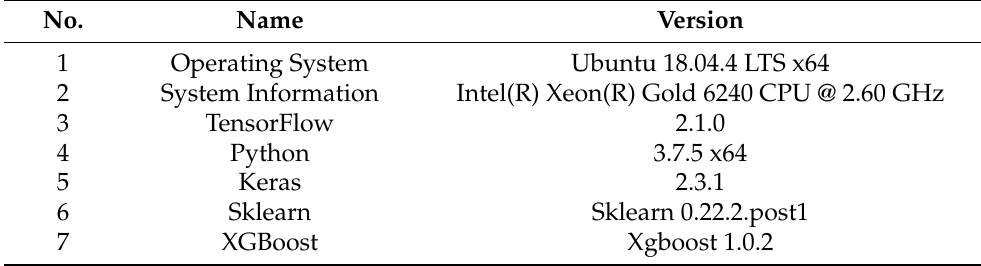
Table 9. Information on the experimental environment.